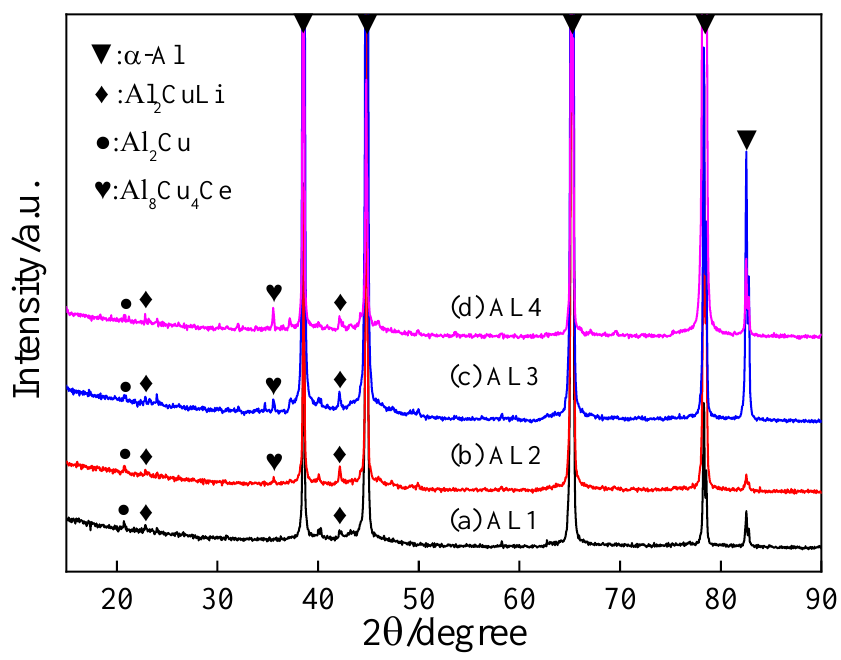
Figure 11. XRD patterns of the alloys after T6 treatment ( a ) AL1; ( b ) AL2; ( c) AL3; ( d ) AL4. Figure 12 shows the selected area electron diffraction (SAED) spectra, TEM bright-field and dark-field images of AL2 alloy with 0.1% Ce and the AL1 alloy without Ce element. As shown in Figure 12a, it can be found that there are bright θ (cid:48) phases in the SAED spectrum along the direction of <100> of AL2 alloy, and the θ (cid:48) phases distributed uniformity. It indicates that a large number of θ (cid:48) phases have precipitated in AL2 alloy. Figure 12b shows the θ (cid:48) phases appear in the TEM bright field image along the direction of <100> of AL1 alloy. However, the number and density of θ (cid:48) phases are relatively fewer compared with AL2 alloy. Bright T 1 phases can be observed in the SAED spectrum along the direction of <112> of AL2 alloy, and there are T 1 phases parallel to each other in dark-field, as shown in Figure 12c. This indicates that a large number of T 1 phases have precipitated in AL2 alloy. From Figure 12d, T 1 phases appear in the TEM dark field image along the direction of <112> of AL1 alloy. The aging precipitated phases in AL1 alloy are T 1 and θ (cid:48) . Compared with AL1 alloy, T 1 and θ (cid:48) phases in AL2 alloy are distributed uniformly. The mechanical properties of AL1-AL4 alloys after T6 treatment are illustrated in Figure 13. It can be found that the ultimate tensile strength increases with the increase of Ce content when the Ce content is less than 0.1%. However, the ultimate tensile strength of the alloy decreases when the Ce content increase to 0.2% and 0.3%. The yield strength exhibits the same trend, while the change of elongation is not obvious, as shown in Figure 13b. Compared with AL1 alloy, when Ce content is 0.1%, the ultimate tensile strength of AL2 alloyincreasese from 484 MPa to 514